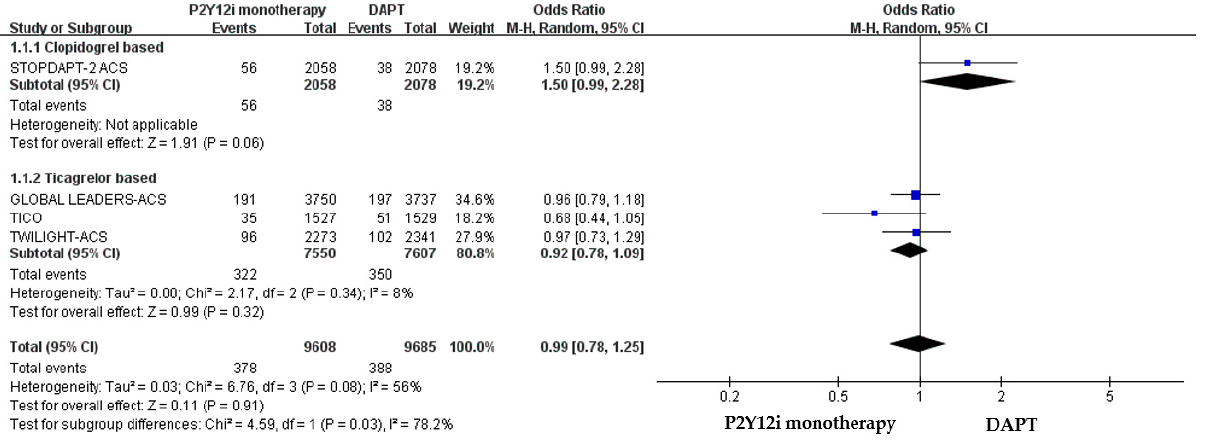
Figure 4. The safety outcomes (major or minor bleeding events) of different P2Y12 inhibitor mono- therapy as compared with 12-month DAPT in patients with ACS after PCI. Figure 5. The NACE of different P2Y12 inhibitor monotherapy as compared with 12-month DAPT in patients with ACS after PCI.